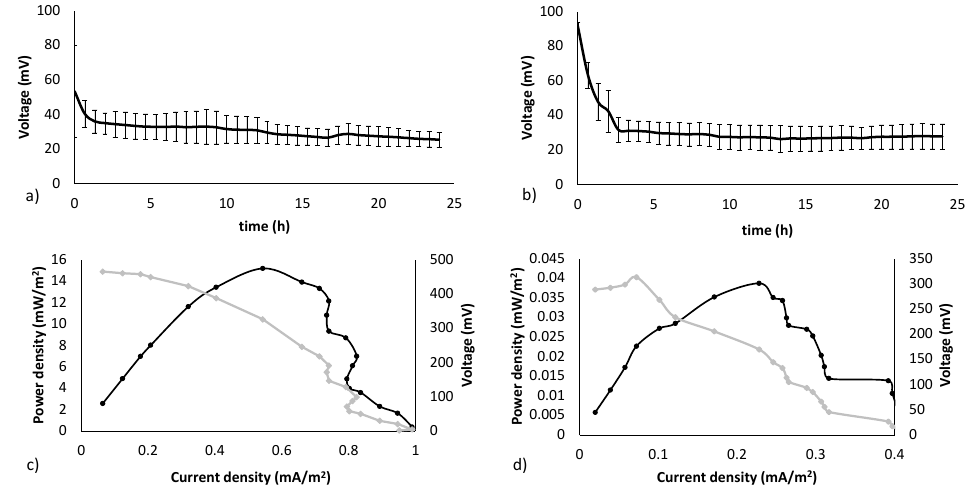
Figure 1. The averaged voltage in an MFC cycle ( n = 7) in ( a ) MFC1 and ( b ) MFC2 and polarization (grey line) and power curves (black line) in ( c ) MFC1 and ( d ) MFC2; bars represent standard deviation; the arrows show the affiliation of the curve to the axis.